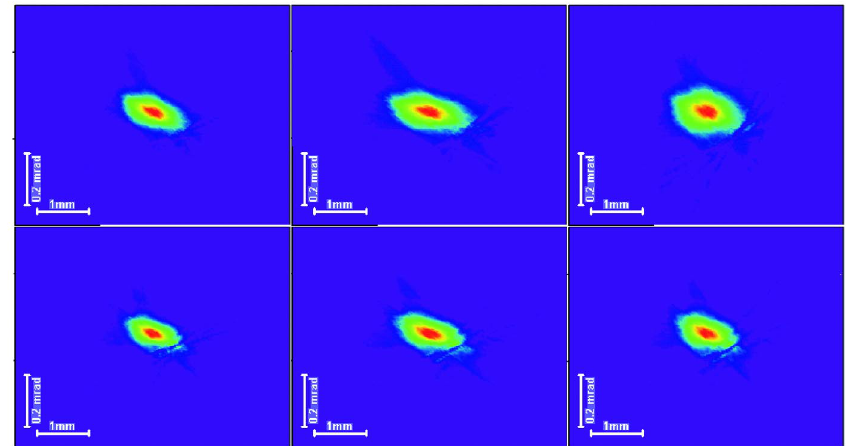
FIG. 10. (Color) Vertical phase-space density distribution of 1.5 ps slices selected out of 9 ps, 0.8 nC (top sequence) and 6 ps, 0.6 nC (bottom sequence) for carefully optimized electron beams. From left to right: front, middle and tail slices of the